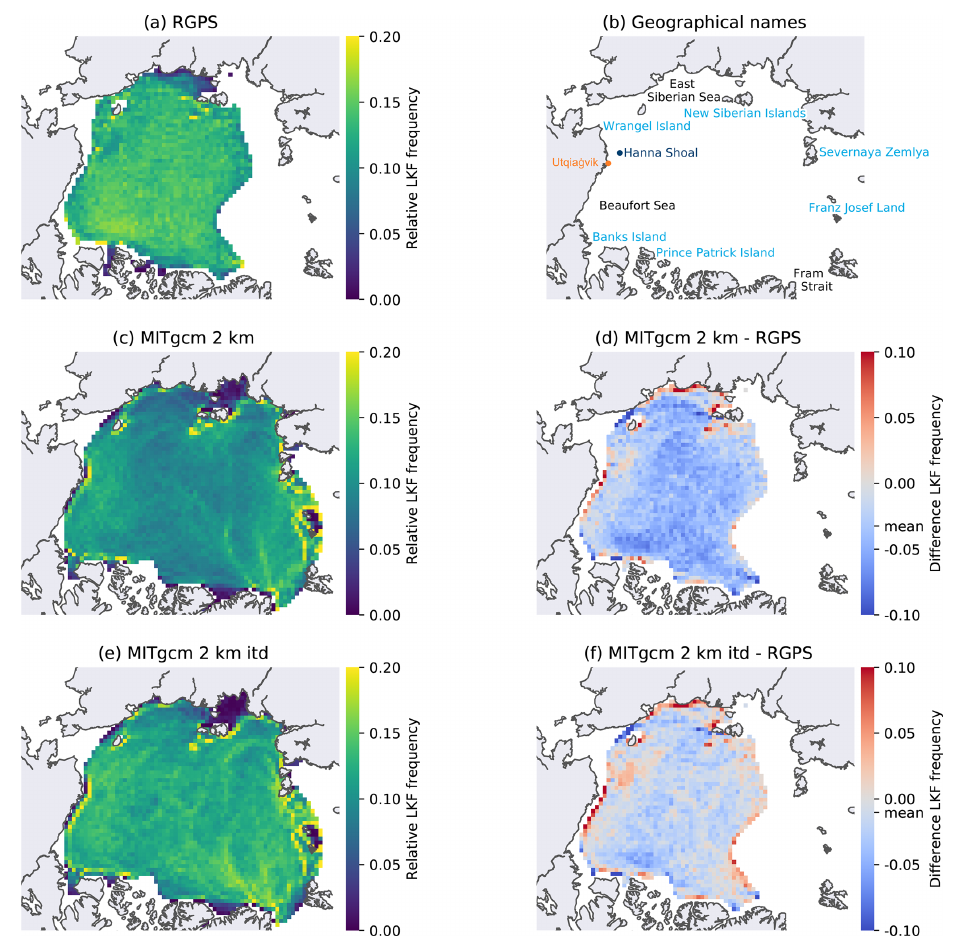
Figure 5. (a, c, e) The density of LKFs in the RGPS dataset and the two model simulations for the winters between 1996 and 2008 computed in 50 × 50km boxes over the Arctic Ocean. The absolute frequency of LKF pixels in a box is normalized by the total number of pixels with deformation in the dataset. Only boxes with more than 500 deformation pixels in space and time are shown. (d, f) The difference in density between both model simulations and RGPS. (b) The geographical locations that are referenced in the